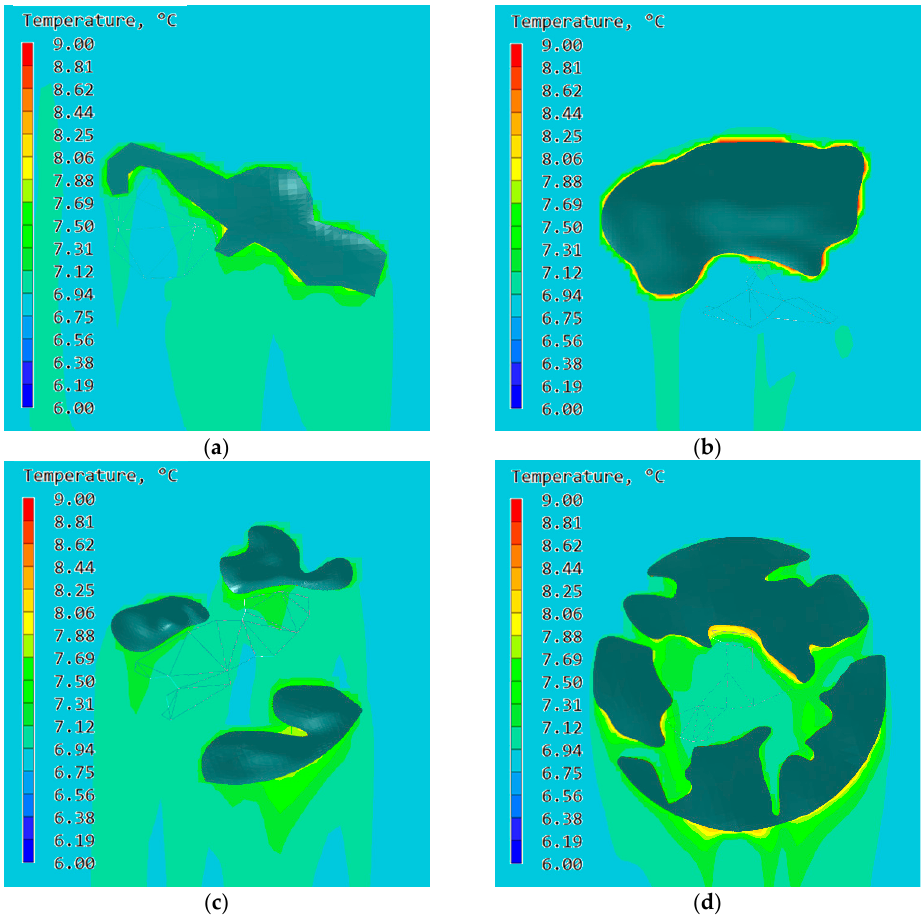
Figure 11. ( a ) Winter thermal environment simulation in Xiasong village; ( b ) Winter thermal environment simulation in Rongfang village; ( c ) Winter thermal environment simulation in Zhuqiao village; ( d ) Winter thermal environment simulation in Xuyuan village.